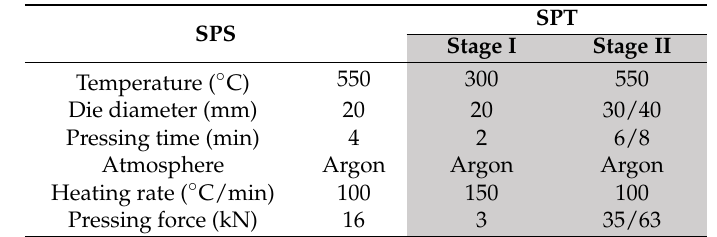
Table 2. Spark Plasma Sintering (SPS) and Spark Plasma Texturing (SPT) process parameters.